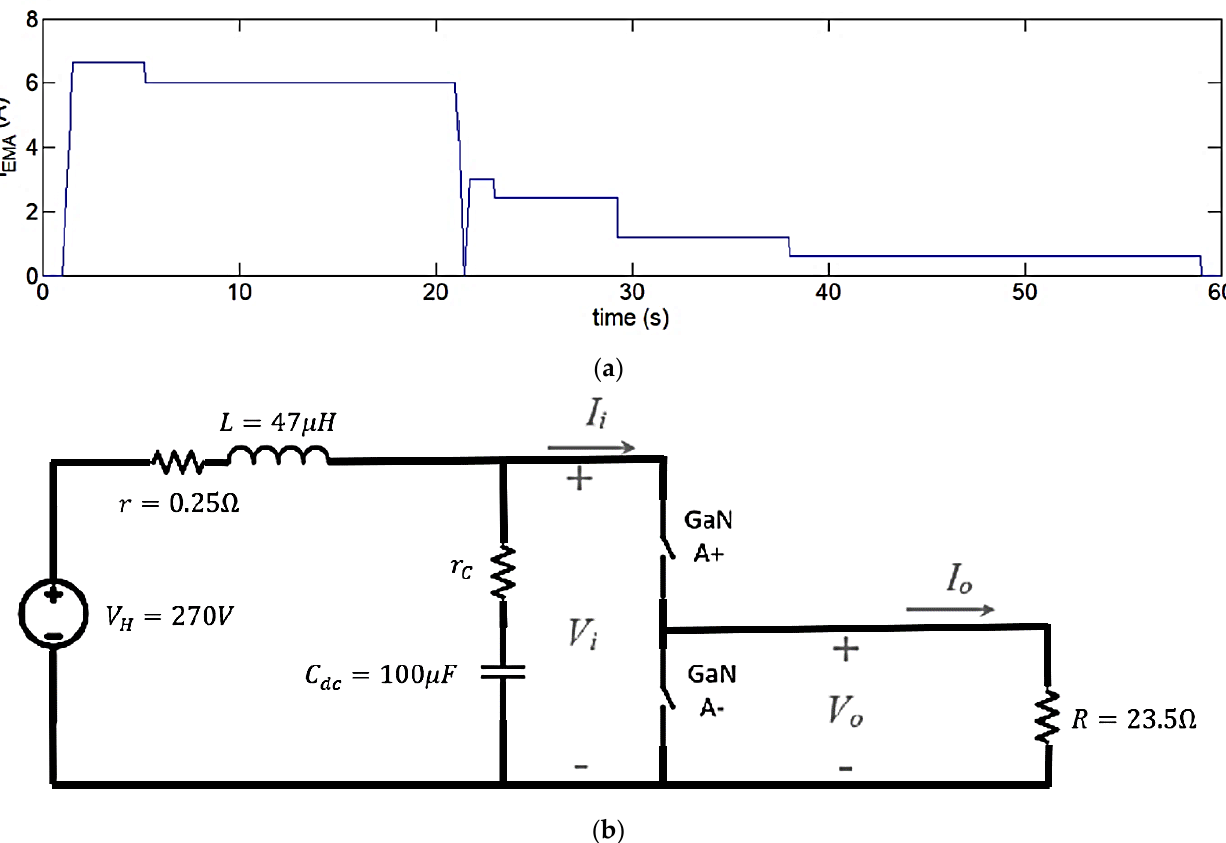
Figure 1. Typical profile of the current absorbed from 270V power bus by a real EMA [4] ( a ) and topology of the developed EMA emulator ( b ).